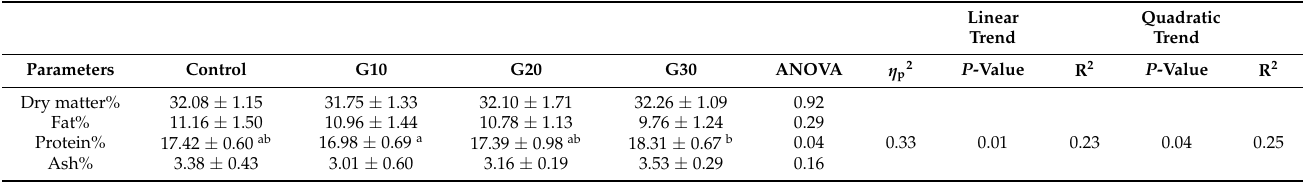
Table 3. Body proximate composition of Eurasian perch consuming feed supplemented with garlic powder.